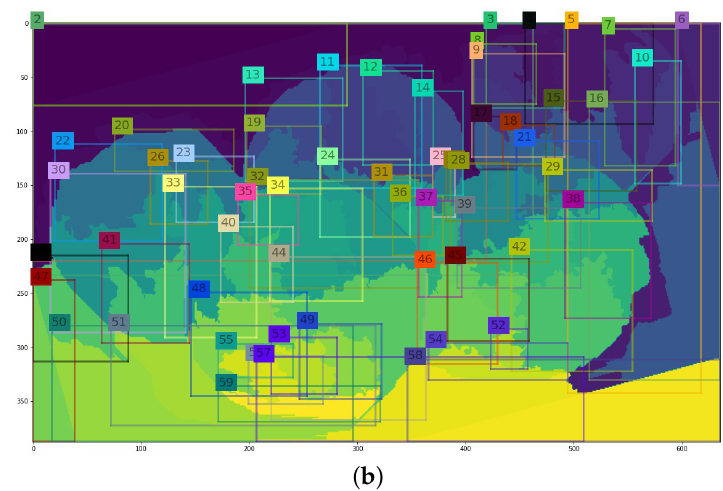
Figure 3. ( a ) Labels on original image and on Felzenszwalb-segmentated image; ( b ) Felzenszwalb- segmented image.